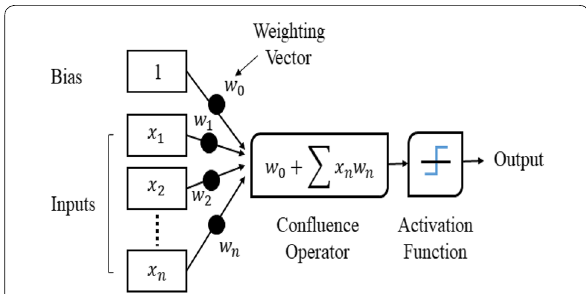
Fig. 1 Structure of an artificial neural